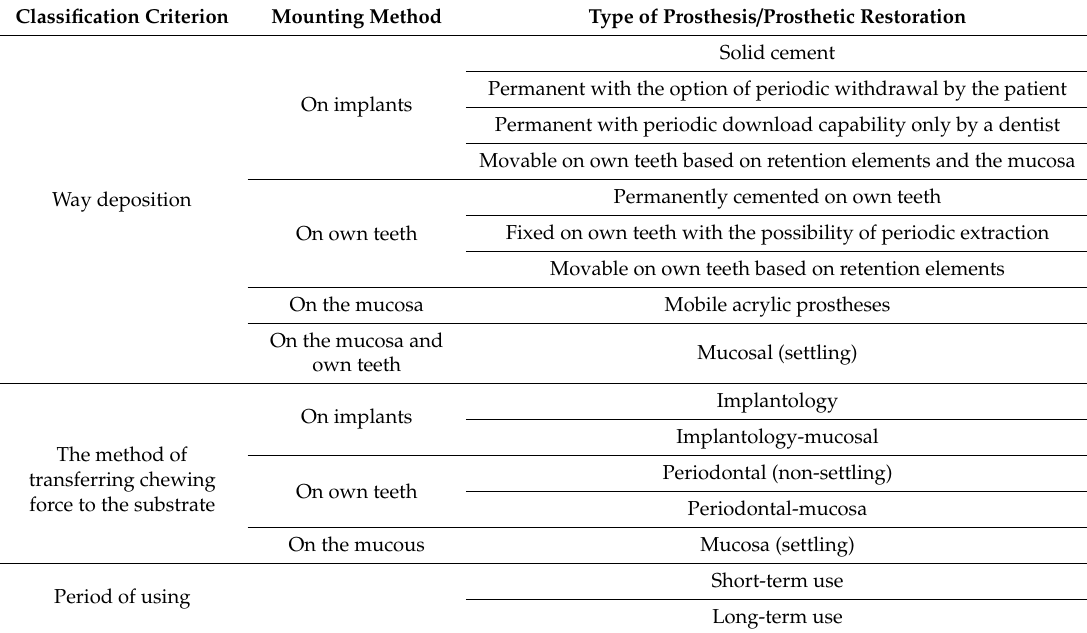
Table 6. The general classification of dental prostheses and prosthetic